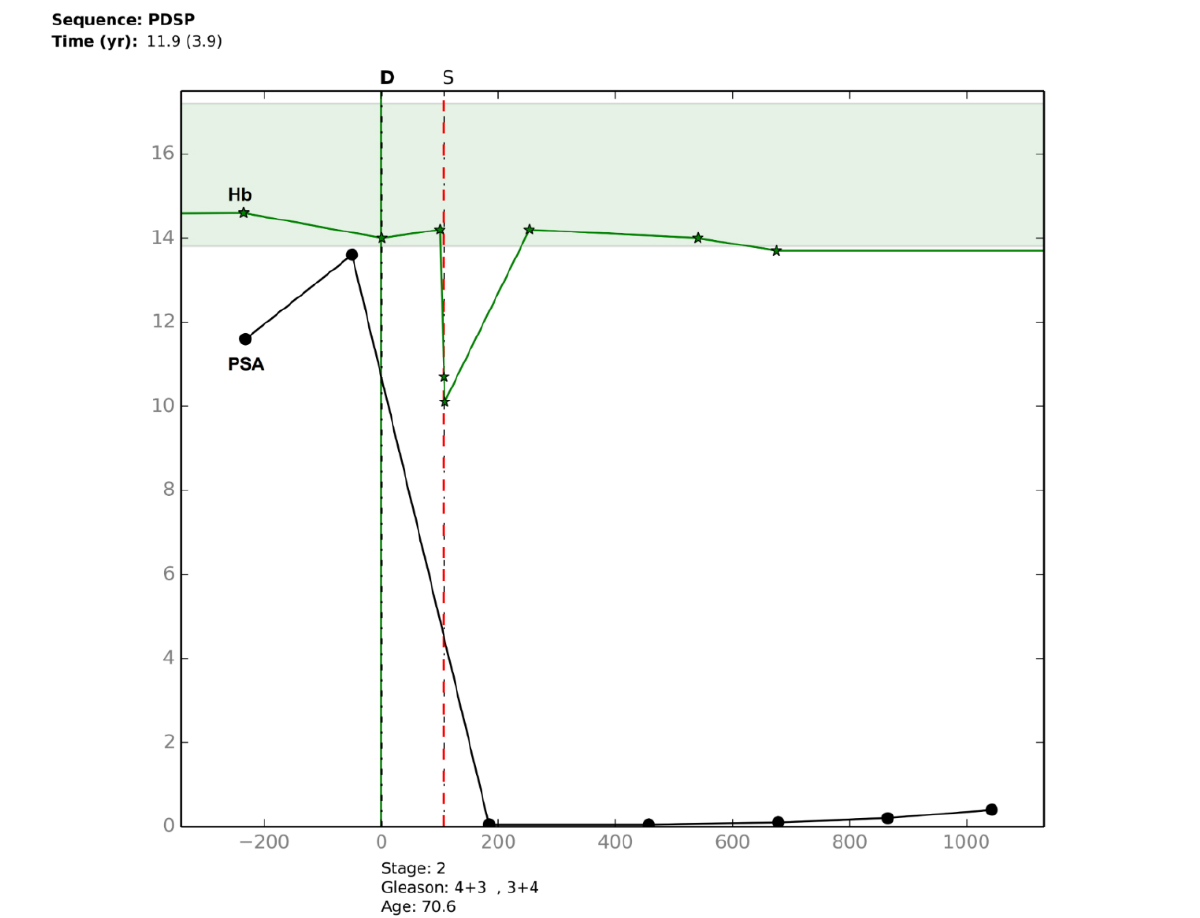
Figure 6. Pathway plot showing the prostate specific antigen (PSA) (round markers) and haemoglobin (Hb) readings (star markers) together. As a result of the prostatectomy event (S) the PSA dropped and Hb also dropped due to normal perioperative bleeding. The shaded area denotes the normal range for